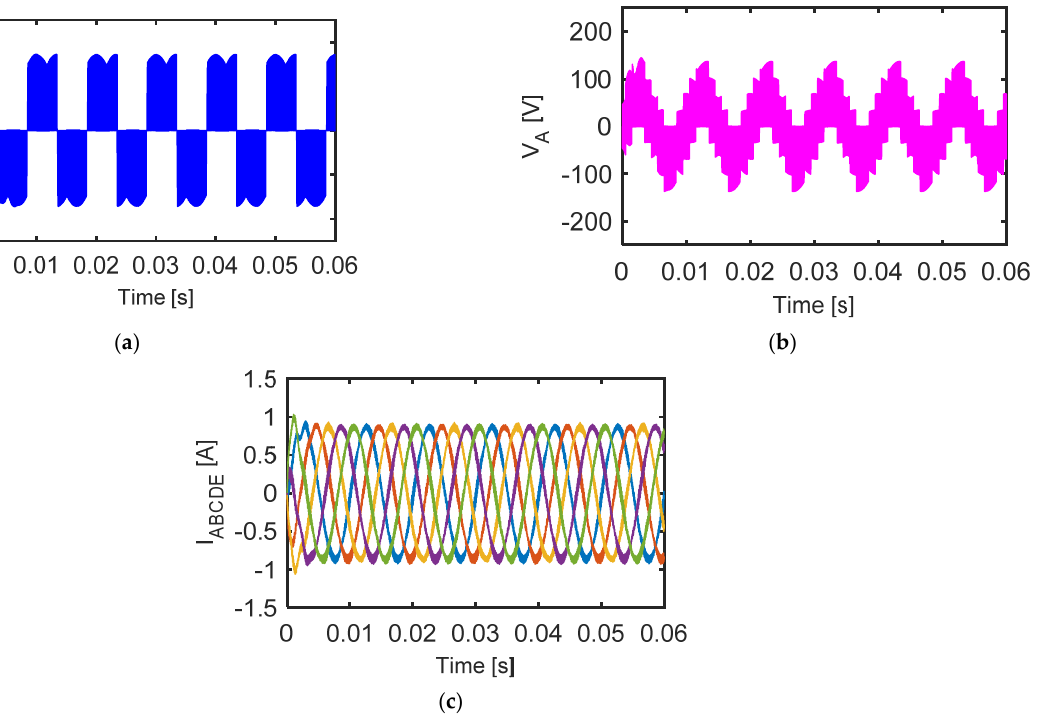
Figure 15. Experimental results ( a ) phase input voltages and ( b ) the voltage of DC link.